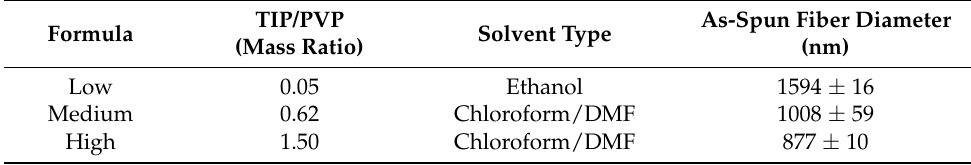
Table 1. Recipe of as-spun green fibers with ceramic